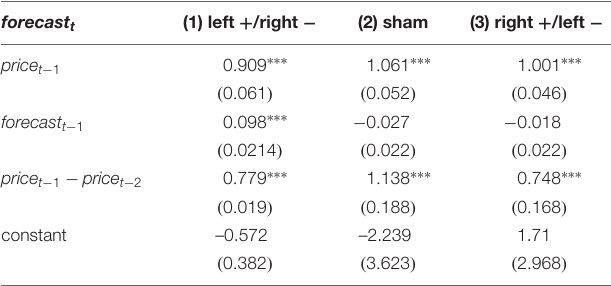
TABLE 3 | Estimated coefficients in the forecasting rules models. forecast